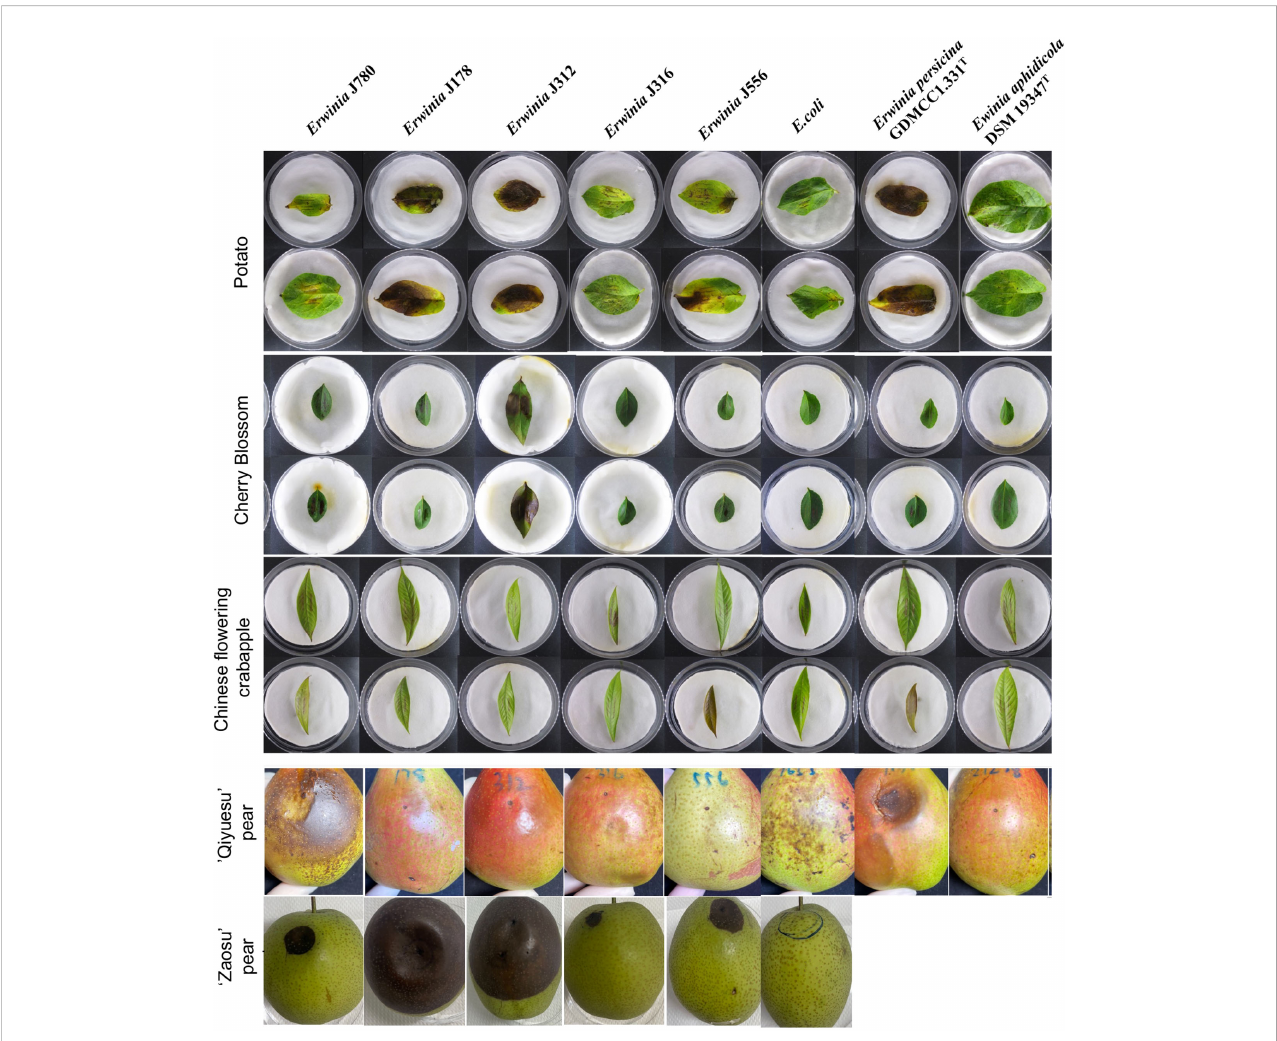
FIGURE 2 The virulence tests on leaves and pear fruits of E. sorbitola sp. nov. and the type strains of the reference strains (strains: J780 T , J178, J312, J316, and J556; reference strains: E. persicina GDMCC 1.331 T and E. aphidicola DSM 19347 T ). The virulence tests on leaves of E. sorbitola sp. nov. were conducted via leaf-clipping method (leaves: potato, cherry blossom, Chinese fl owering crabapple); the virulence tests on fruits of E. sorbitola sp. nov. were conducted via injection into pear fruits by needle (fruits: ‘ Qiyuesu ’ pear, ‘ Zaosu ’ pear). The infection dose was 1×10 7 CFU/mL, leaves were incubated for three days, and fruits were incubated for 14 days. E. coli was used as negative control strain. Experiments were repeated